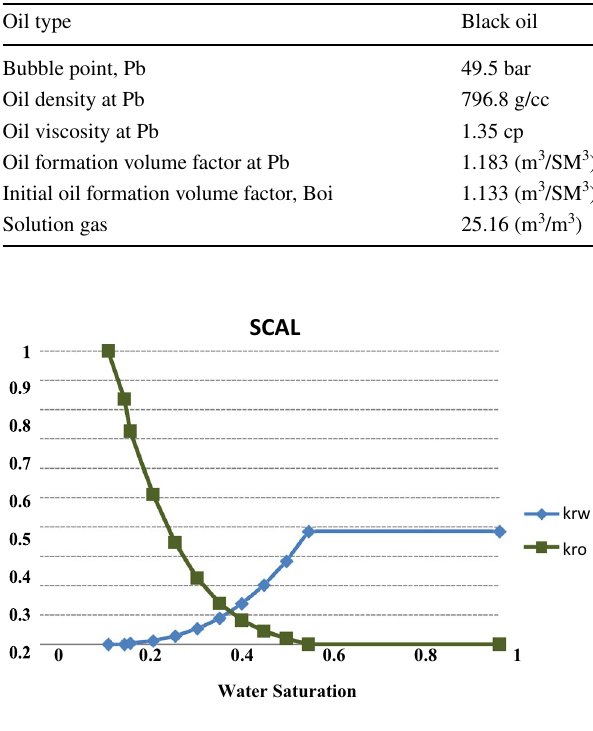
Fig. 4 Water–oil relative permeability